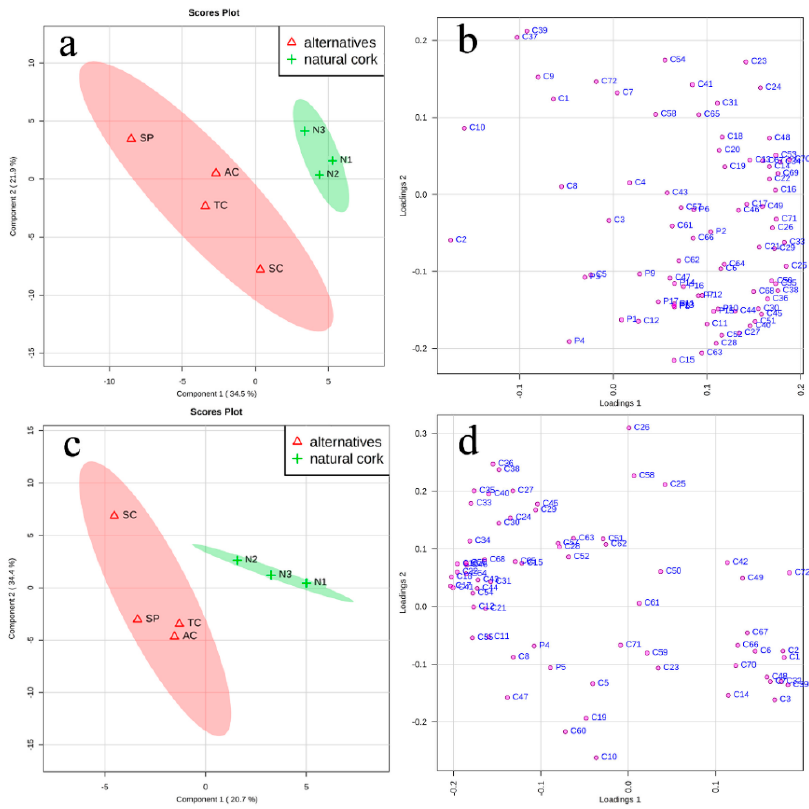
Figure 5. PLS-DA of flavor compounds in 18-month bottle-aged wines treated with natural corks and their alternatives. ( a ) PLS-DA model for rosé wine differentiation; ( b ) scattering plot of PLS-DA model for rosé wines; ( c ) PLS-DA model for white wine differentiation; ( d ) scattering plot of PLS-DA model for white wines. Note: Flavor compounds ′ numbers in Figure 5b,d are provided in Tables S1,S2. Table 1. Differentiated flavor compounds in rosé and white wines (VIP > 1, p < 0.05). No.